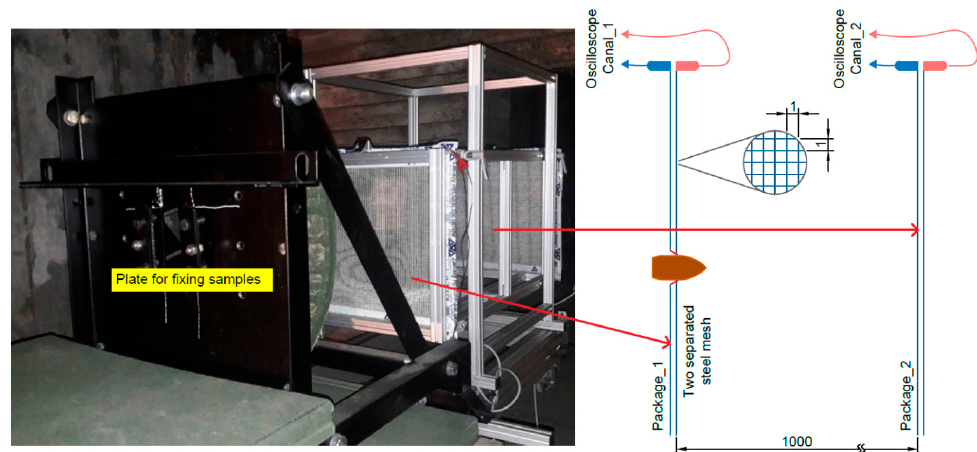
Figure 2. View of the optoelectronic gate to measure the velocity of projectiles before penetrating the sample.